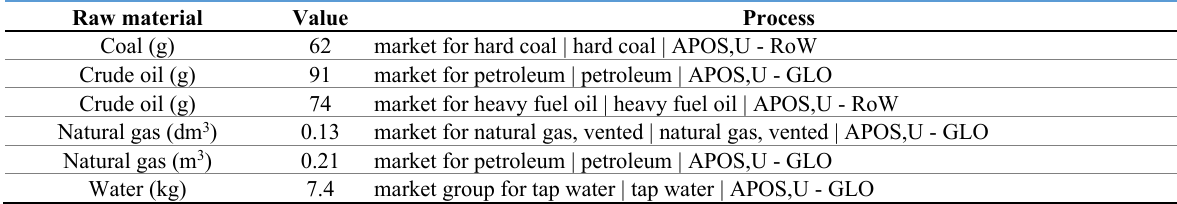
Table 4. Raw inputs for superplasticizing admixture